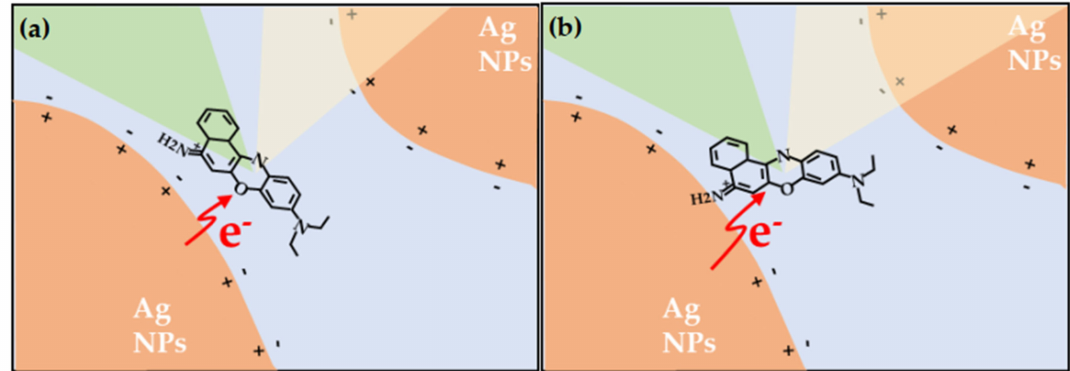
Figure 17. The charge transfer mechanism of single-molecule electrochemistry: ( a ) Before and ( b ) after.